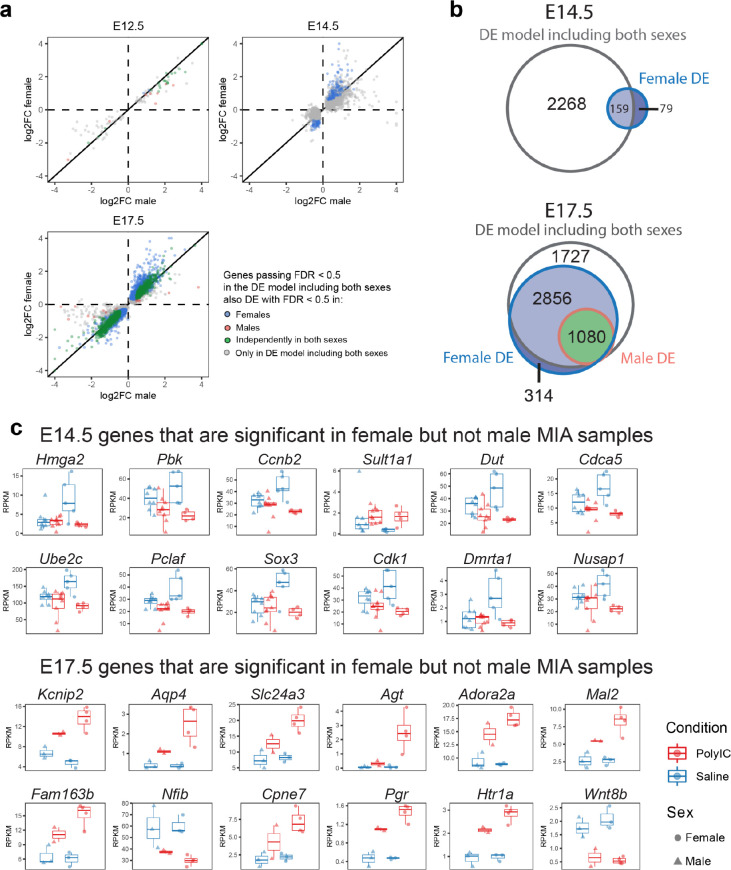
Sex-stratified comparison of DE genes and effect sizes suggest increased DE effect sizes in females.(a) Correlation of the relative effect sizes (log2FC) for genes passing FDR < 0.05 identifies high degree of concordance between MIA responses between sexes. Genes passing FDR threshold in either or both sexes are color coded. (b) Venn diagrams illustrating overlap between DE gene sets passing FDR < 0.05 at E14.5 and E17.5, in DE models containing samples from both sexes, males, or females. The DE model comprising individuals of both sexes includes most of the DE signature of each sex. Female DE analysis identifies limited and unique DE signature. (c) Examples of E14.5 and E17.5 genes significant in females but not males. At E14.5 genes were selected to pass FDR < 0.05 and logFC > 0.5 or logFC < −0.5 in females, but not logFC > 0.5 or logFC < −0.5 in males. The gene-set selection process was analogous for E17.5 with the addition of FDR < 0.05 condition in males. After gene set filtering, twelve genes with the lowest FDR in females were plotted.